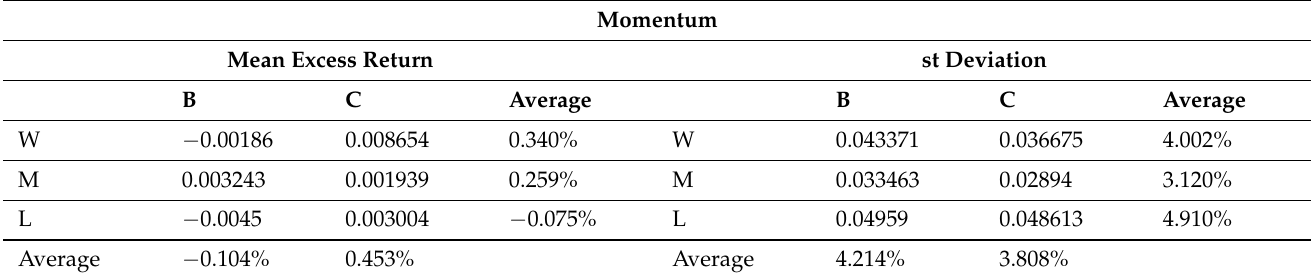
Table 4. Average excess returns per month for portfolios built using size and